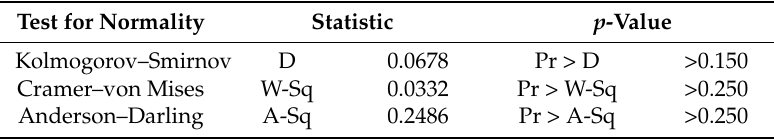
Table 7. Tests for normality on residuals associated with the Table 6